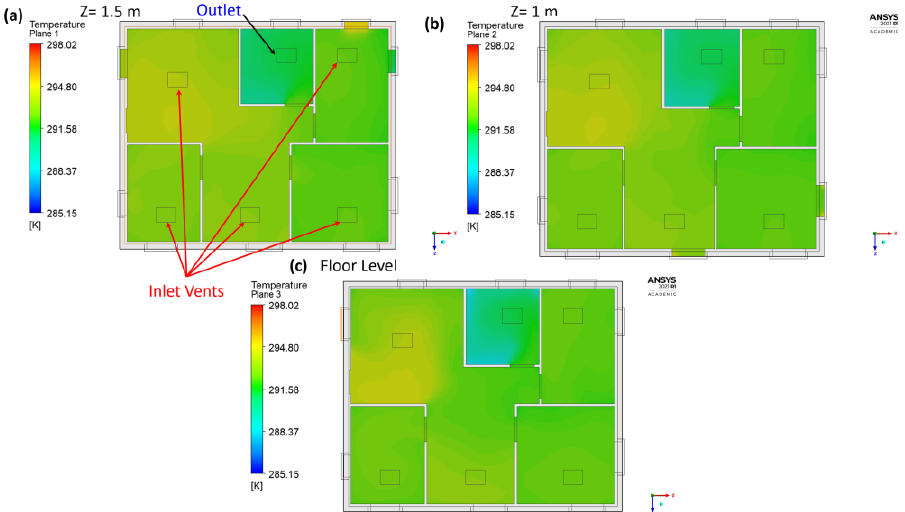
Figure 7. Temperature profiles distribution for the house (top view) using Healthy Home standards 2019 inlet temperature 20 ℃ at different heights ( a ) 1.5 m, ( b ) 1 m, and ( c ) the (finished) floor.